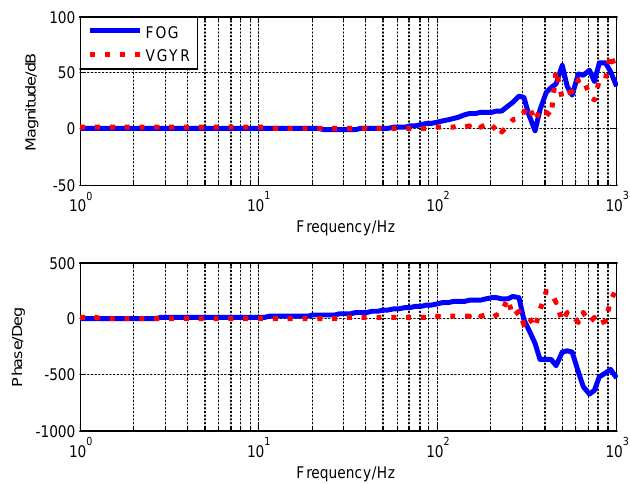
Figure 9. The comparison of the characteristics between FOG and VGYR in frequency domain.